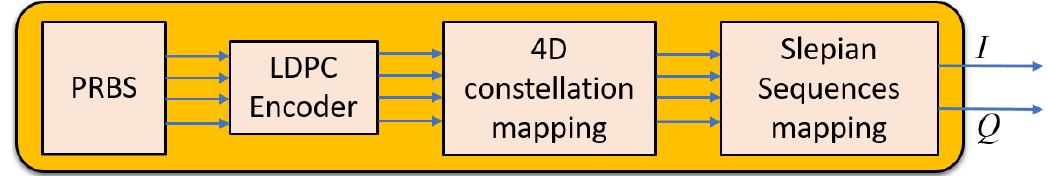
Figure 2. Slepian sequences-based 4D LDPC-coded transmitter.